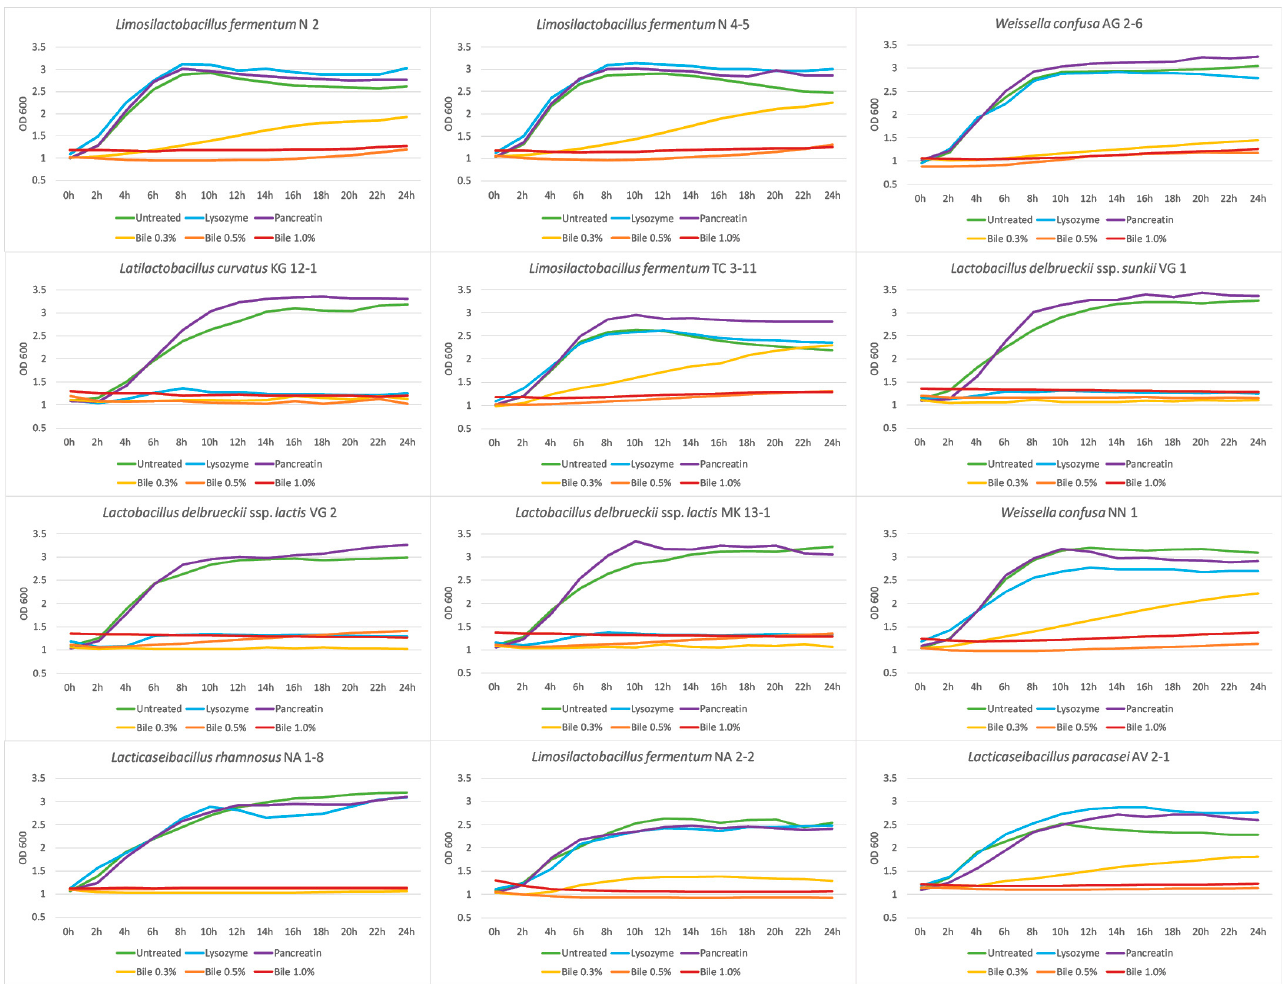
Figure 3. Growth dynamics of the newly isolated lactic acid bacterial strains in the presence of gastrointestinal stress factors.